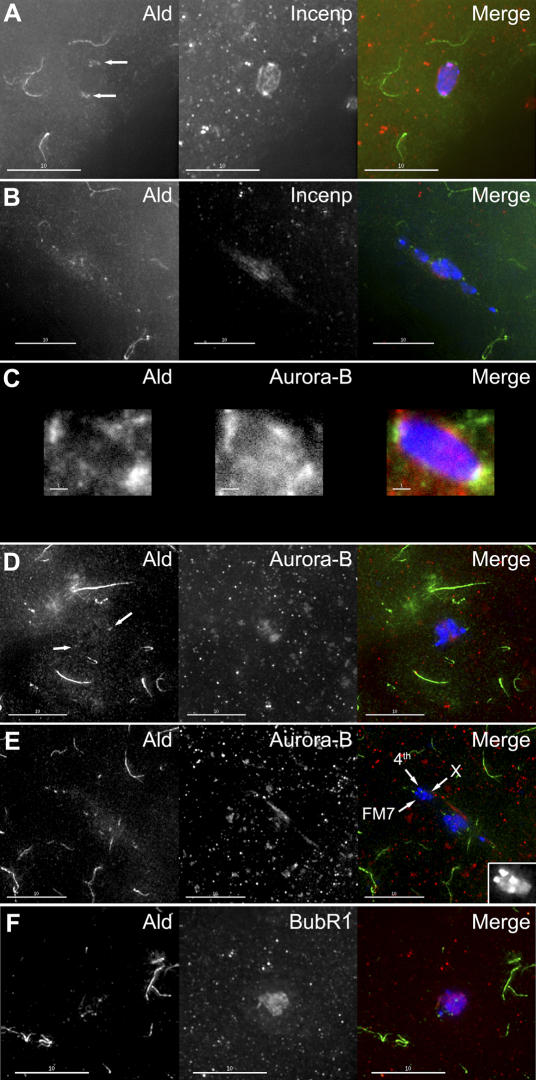
Incenp and Aurora-B Colocalize to the Meiotic Spindle but Not to Ald FilamentsAll oocytes are from FM7/yw; pol females, hybridized with anti-Ald plus either anti-Aurora-B, anti-Incenp, or anti-BubR1 antibodies. Each oocyte shows Ald, (left panel); Aurora-B, Incenp, or BubR1 (middle panel); and DAPI (right panel). The high background off of the oocyte nucleus is from the large amount of maternally loaded protein. In no figure were Aurora-B or Incenp protein found to localize to the Ald cytoplasmic filaments.(A) An early prometaphase oocyte nucleus, showing inner-kinetochore Incenp localization and less-punctate staining along the spindle. Arrows: kinetochore-associated Ald foci.(B) A metaphase-arrested oocyte nucleus, showing no Incenp kinetochore localization and diffuse localization near the metaphase plate.(C) A magnification of the chromosomes in an early prometaphase oocyte nucleus, showing localization of Aurora-B to the kinetochores and spindle. While this staining was weaker than Incenp, and not greatly above background, in the full z-stack the brightest kinetochore localization was clearly in the same optical section as both the tips of the DNA and the Ald kinetochore foci.(D) A mid-prometaphase oocyte nucleus showing Aurora-B localization along the metaphase plate, but not to the cytoplasmic Ald filaments. Arrows: kinetochore-associated Ald foci.(E) A mid-late prometaphase oocyte nucleus, with a stripe of Aurora-B localization to one side of the spindle midbody. Note that both X chromosomes are physically associated with each other and one Chromosome 4 on the same side of the spindle (labels). X and FM7 can be discriminated by the pattern of DAPI staining of heterochromatin. Inset: A 2× enlargement of the DAPI signal for the two X chromosomes and one 4 chromosome.(F) A mid-prometaphase oocyte nucleus with Ald and BubR1 staining. The spindle is pointing into the plane of the image. Note the Ald at kinetochores and the localization of BubR1 on the chromosomes.